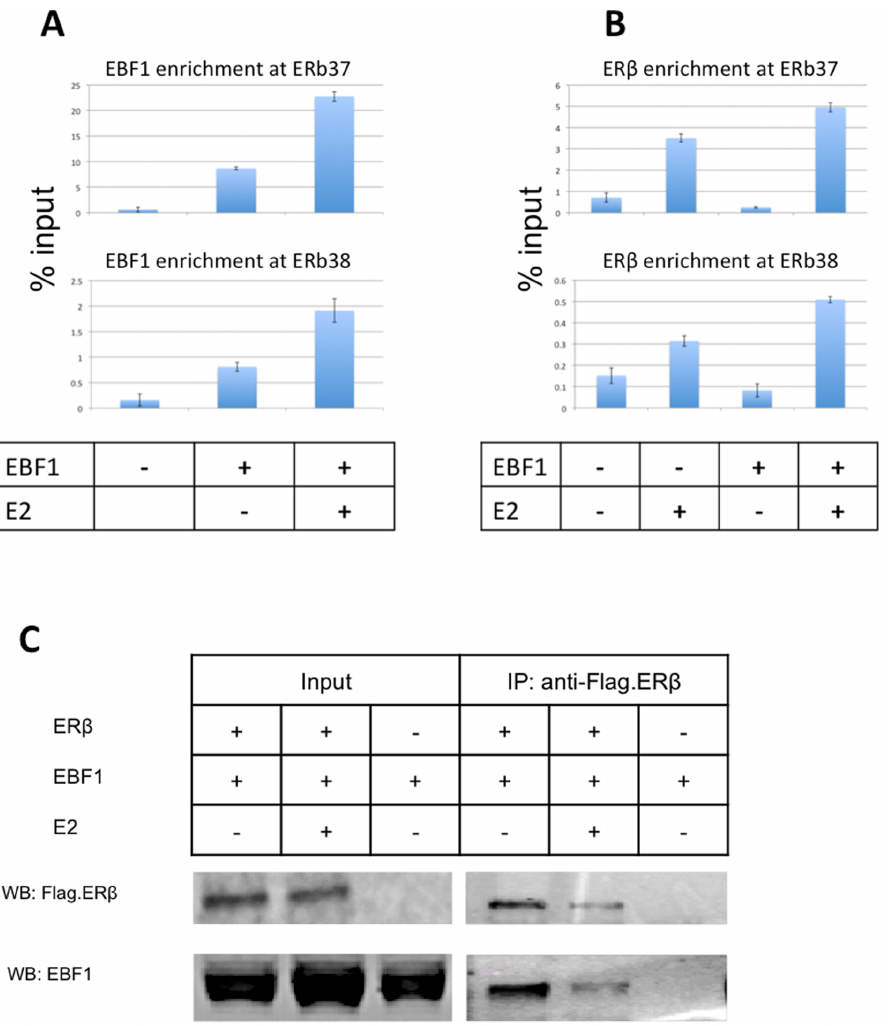
Figure 6. The association between ER b and EBF1. C4–12/Flag.ER b cells were transfected withV5-tagged EBF1 and incubated for 1 hr with 10 nM E2. Cells were then treated with 1% formaldehyde and processed by ChIP assay using (A) anti-V5 antibody and (B) anti-Flag M2 antibody. (C) C4–12/Flag.ER b cells were transfected with V5-tagged EBF1, treated with 10 nM E2, lysed and subjected to co-immunoprecipitation using anti-Flag M2 antibody to immunoprecipitate complexes containing Flag.ER b . Anti-Flag M2 antibody and anti-V5 antibody were used on Western blots to detect V5.EBF1 and Flag.ER b , respectively.